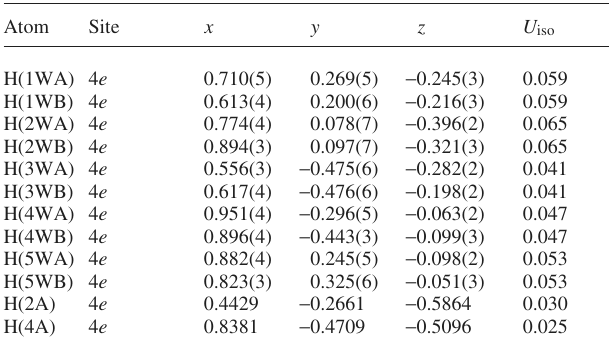
Table 2. Atomic coordinates and displacement parameters (in Å 2 )